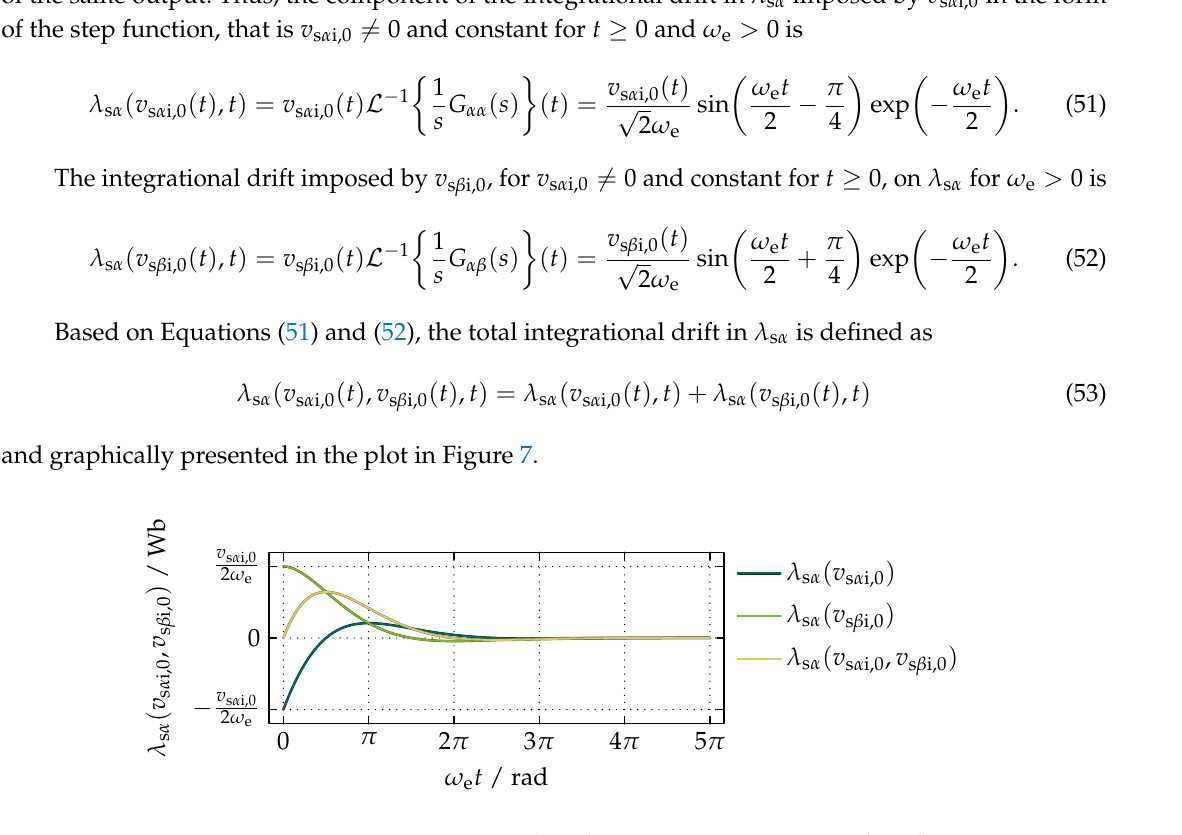
Figure 7. A plot of λ s α with the component λ s α ( v s α i,0 ) imposed by v s α i,0 and λ s α ( v s β i,0 ) imposed